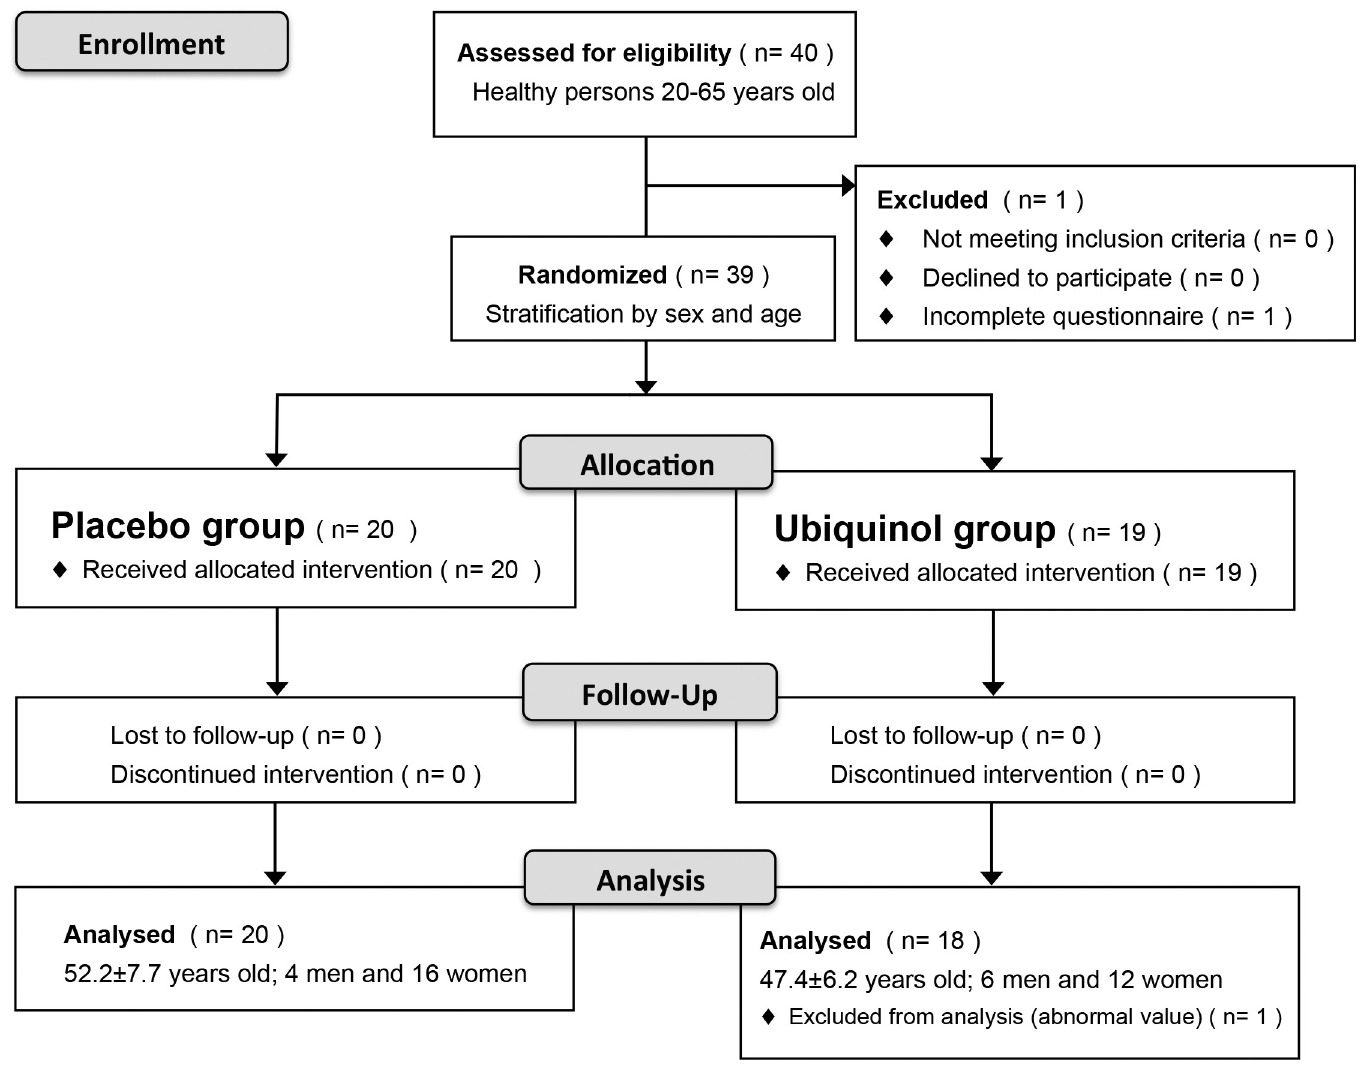
Fig 1. Clinical trial flow